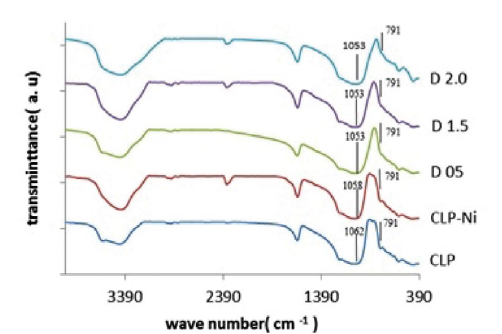
Fig. 3. Ni 2+ content of the product zeolite agglomerates as a function of the NaOH solution molarity.